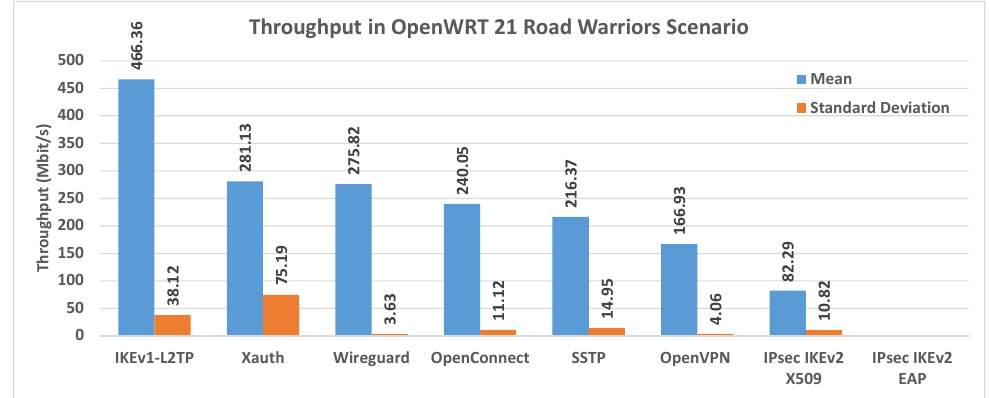
Figure 19. Comparison of Throughputs on OpenWRT 21 in all scenarios.